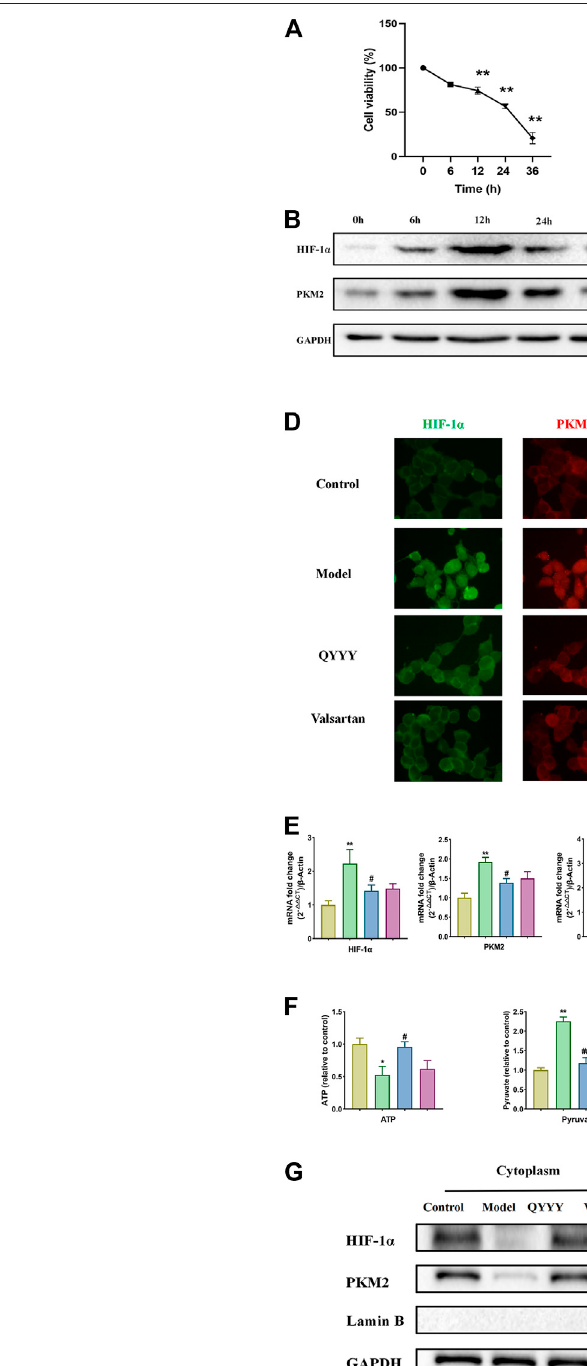
Frontiers in Pharmacology |